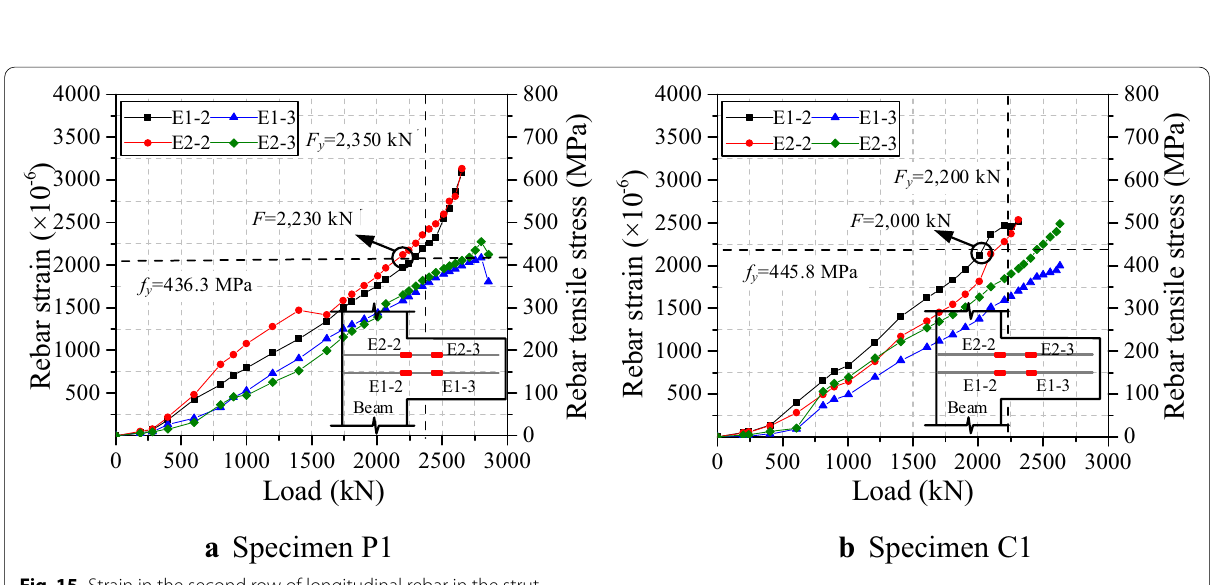
Fig. 15 Strain in the second row of longitudinal rebar in the